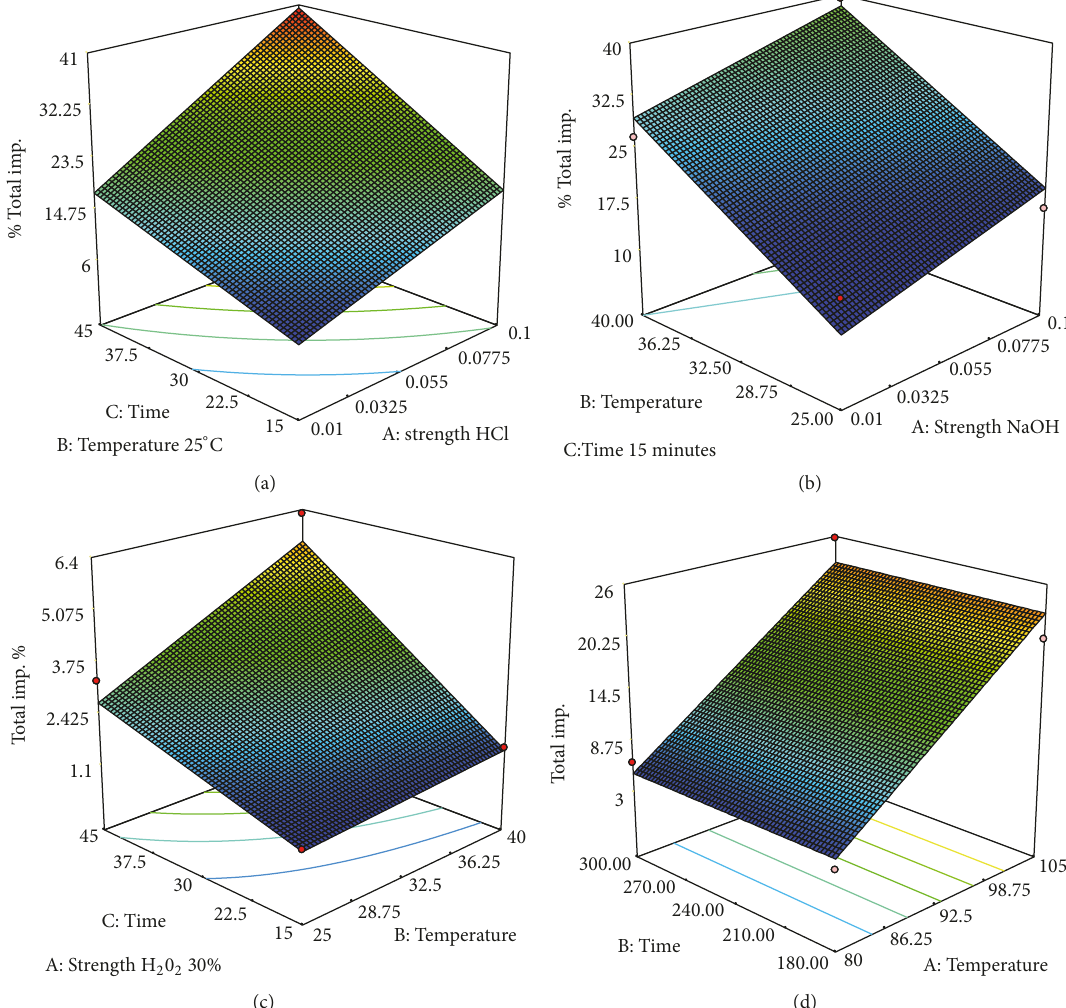
Figure 4: 3D response surface plots showing the desired degradation under various conditions: (a) acid degradation; (b) alkali degradation; (c) oxidative degradation; and (d) thermal degradation. Color change from blue to red represents increasing degradation (min